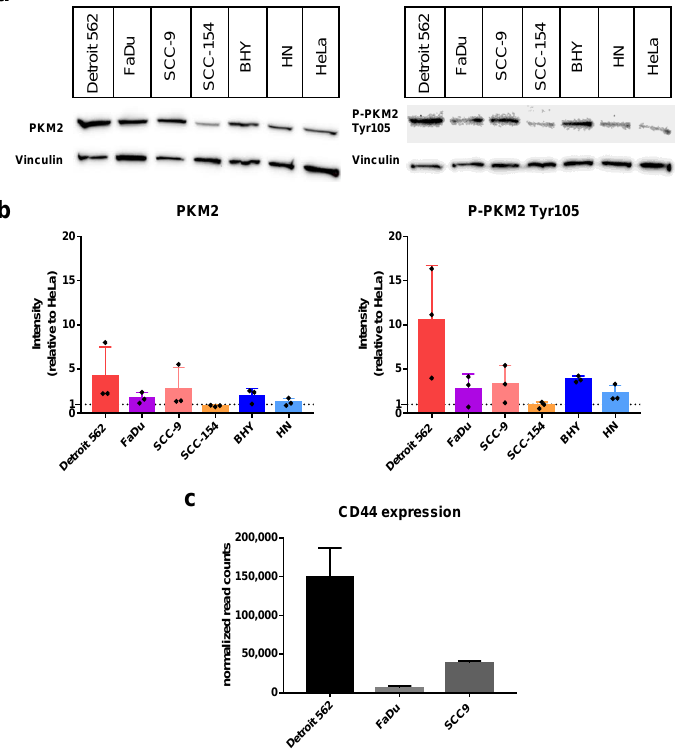
Figure 1. Abundance of PKM2 and its variant P-PKM2 Tyr105 in HNSCC cell lines. ( a ) Western blots of indicated cell lysates with an antibody specific for PKM2 (left) or P-PKM2 Tyr105 (right). For controlling equal loading, upper parts of blots were incubated with an antibody specific for Vinculin. ( b ) Graphs displaying Western-blot intensities relative to result for Hela reference cell line. Shown are mean values and SD of four independent experiments as depicted in ( a ). Vinculin intensities were used for normalization. ( c ) Normalized expression levels of the gene CD44 obtained by mRNA sequencing (see [37] for details on sequencing).